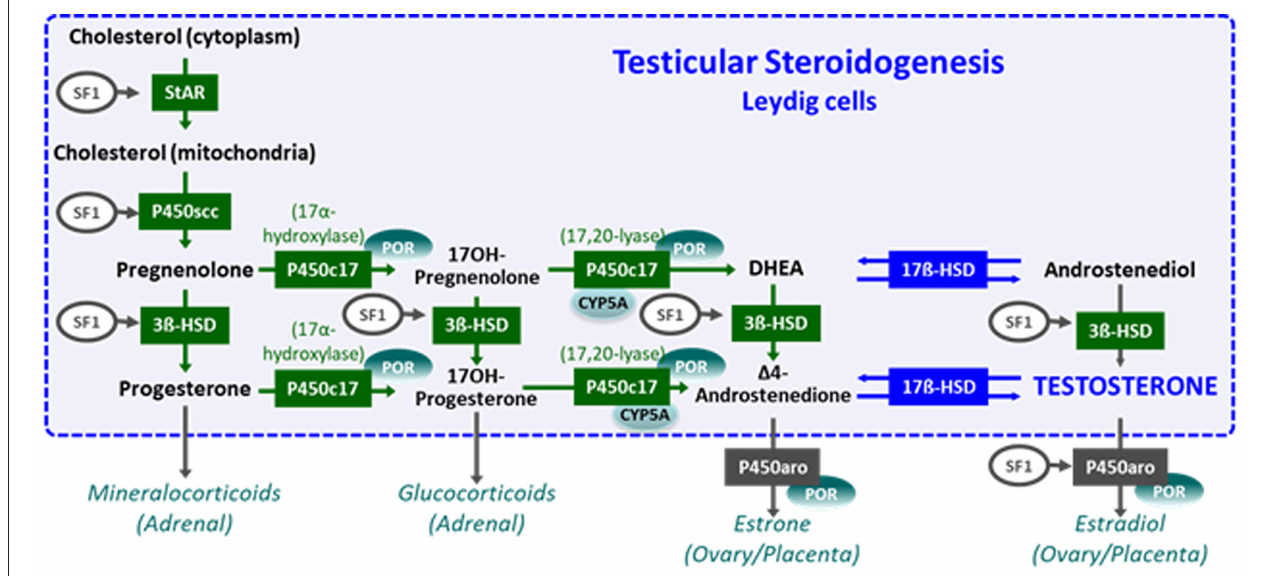
FIGURE 5 | Steroidogenesis steps in testicular Leydig cells (within the dotted blue box) and in the adrenals, ovaries, and placenta (outside the box). Reproduced with permission from (49). Copyright © 2020 Grinspon, Bergadá and